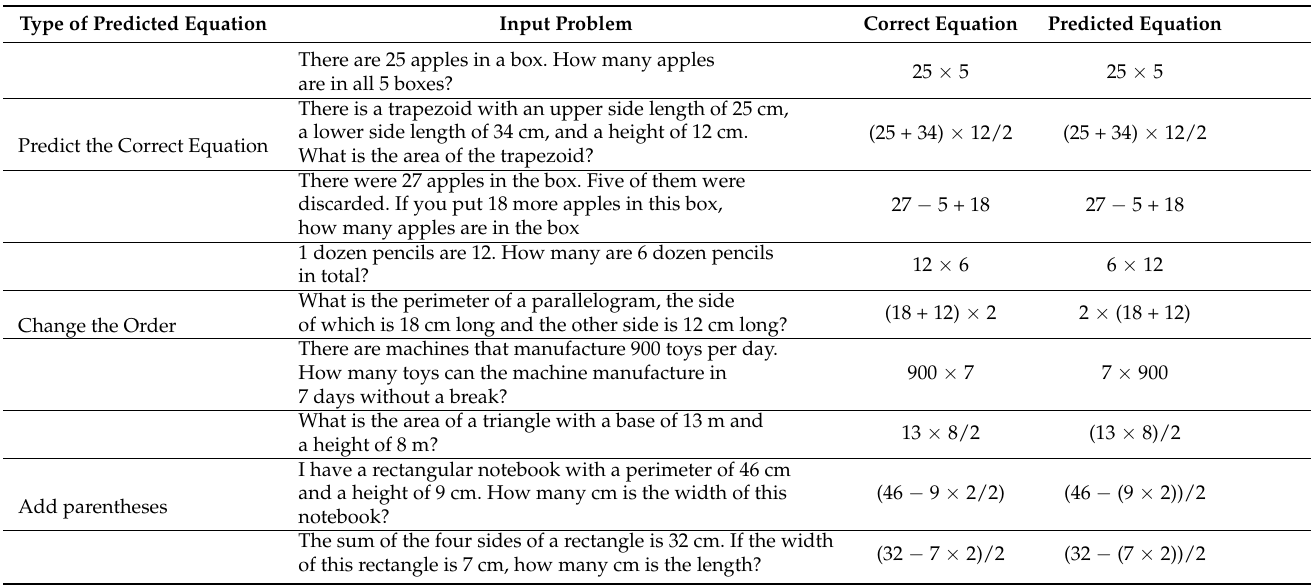
Table 8. Equation form that manifests when a Transformer anticipates an